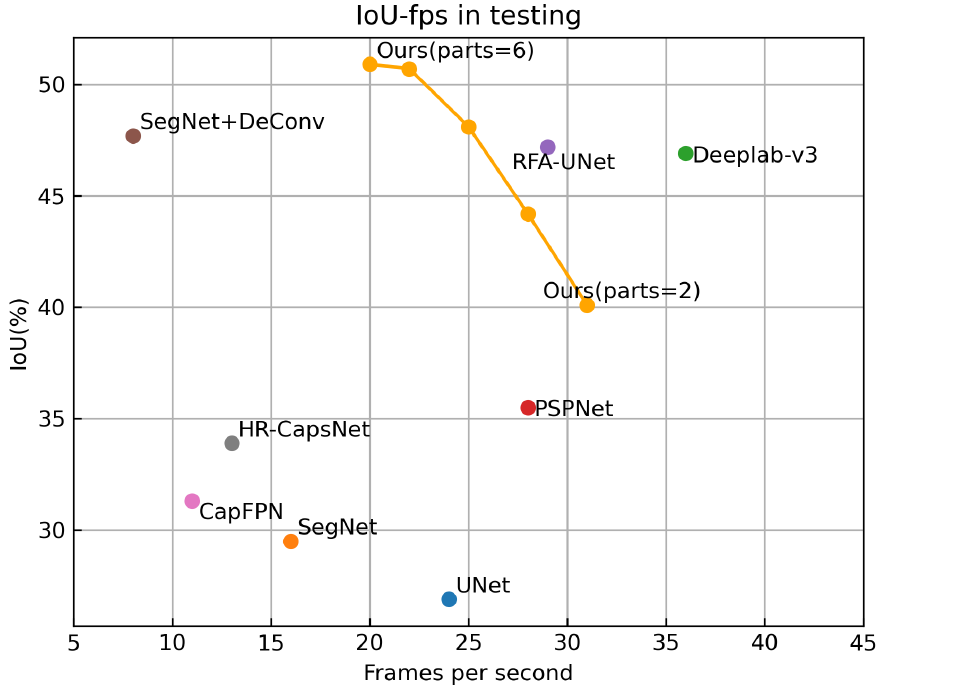
Figure 9. The efficiency comparison of different